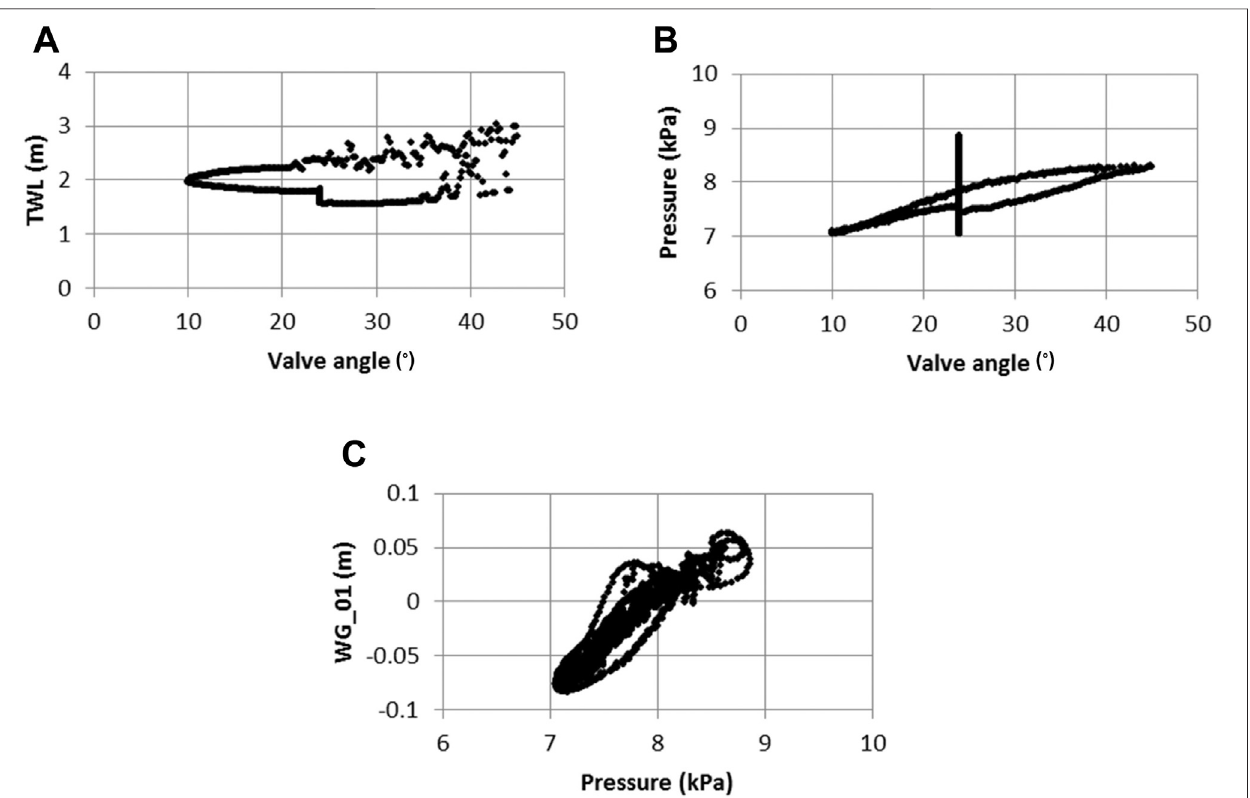
FIGURE9| Comparisonoftimeco-incidentvaluesfor (A) valveangleandtankwaterlevel, (B) valveangleandpressureatthebaseoftheTSand (C) pressureatthe base of the TS and free-surface elevation at WG_01 (0.25 m from TS) for second generation TS.